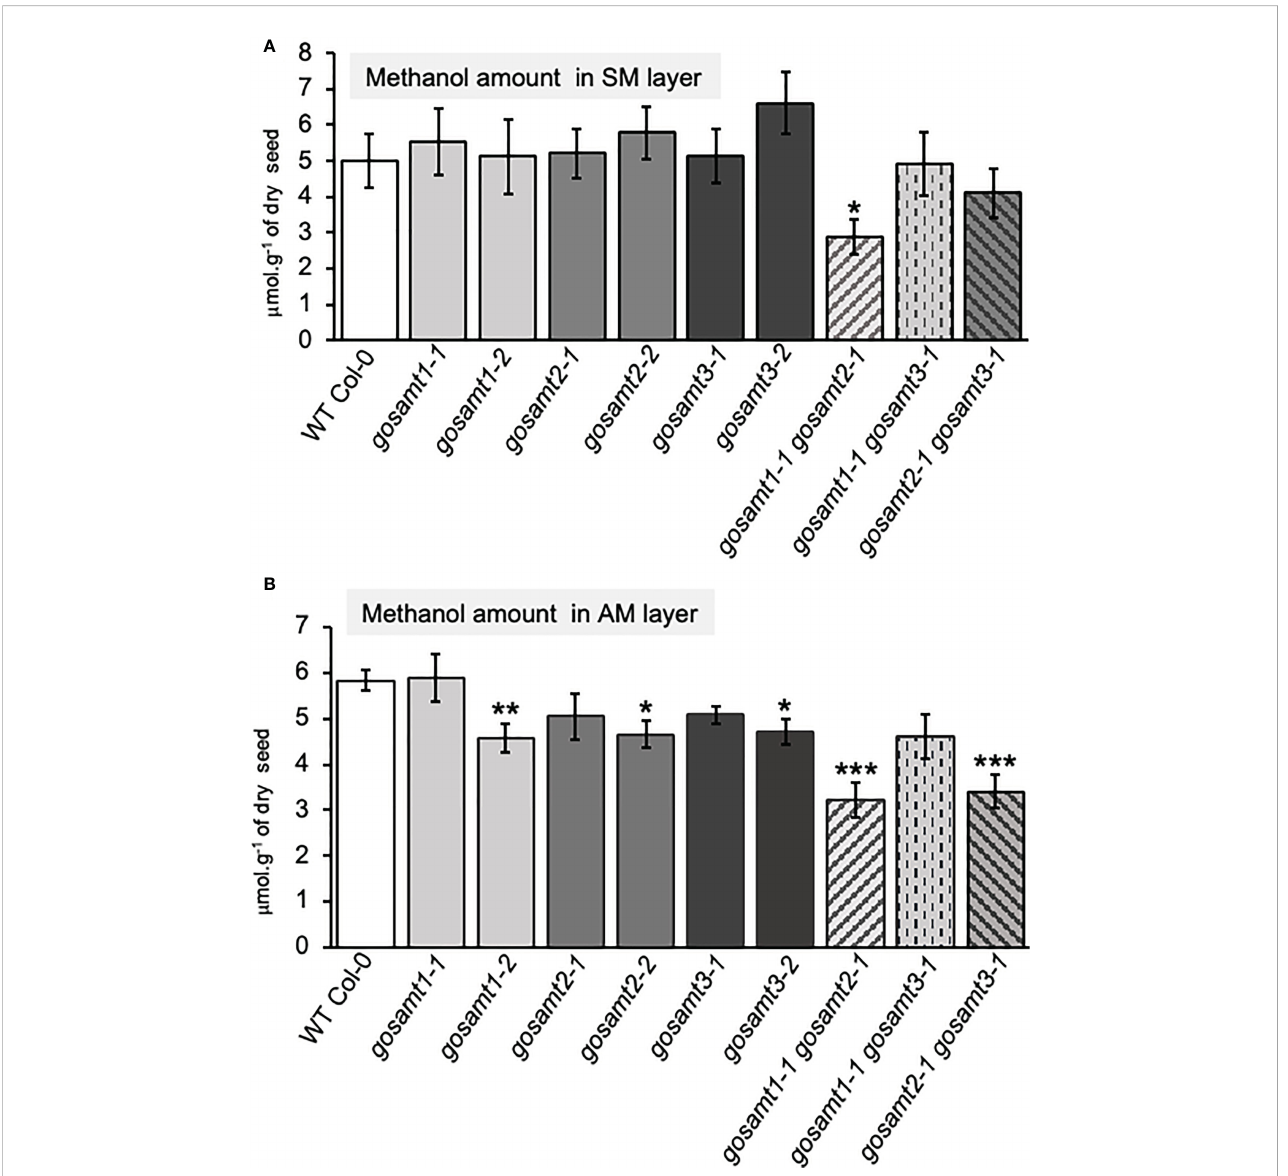
FIGURE 4 Methanol content of gosamts single and double mutants mucilage layers is altered in comparison to the wild-type. Methanol content in soluble (A) and adherent (B) mucilage layers determined after saponi fi cation. Error bars represent SE from fi ve technical replicates of three biological replicates ( n = 15); asterisks indicate signi fi cant statistical differences detected by t -test to compare mutant lines with their respective wild-type (* P < 0.05; ** P < 0.01, *** P <